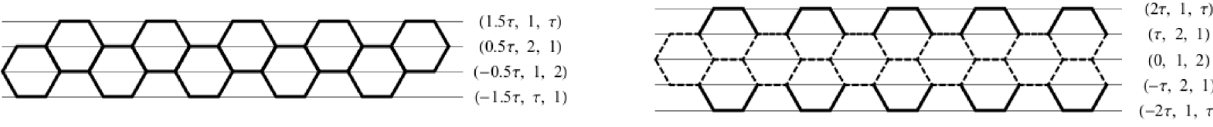
Figure 4. A ring of hexagons from the middle of the surface of C 60 and C 70 unwrapped into the plane. Horizontal lines indicate positions of the four H 2 decagons in C 60 and five H 2 decagons in C 70 . The dominant points identify the H 2 decagons relative to the basis f a 1 , v 2 , v 3 g . Dashed lines are the boundaries of the ring of five inserted hexagons.